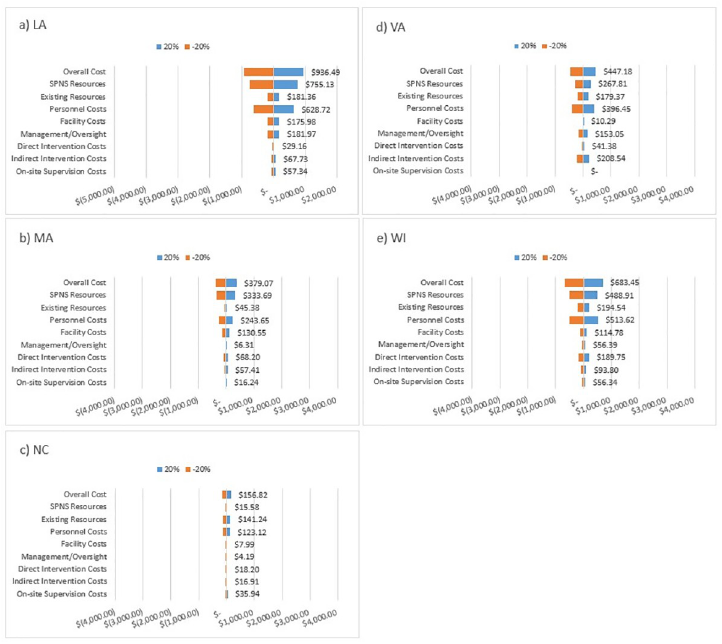
Fig 2. Sensitivity analyses: Effect of fluctuation in costs on the cost per outcome of patient navigation interventions. LA, Louisiana; MA, Massachusetts; NC, North Carolina; SPNS, Special Projects of National Significance; VA, Virginia; WI,